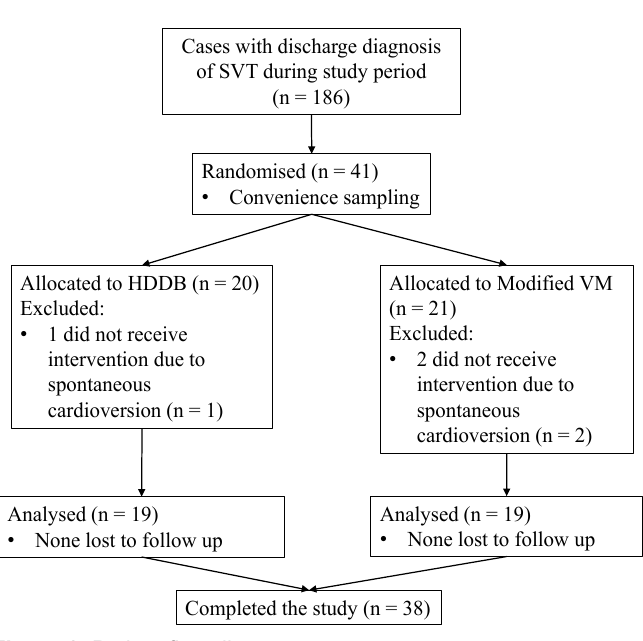
Figure 2. Patient flow diagram. SVT , supraventricular tachycardia; HDDB , head down deep breathing; VM , Valsalva